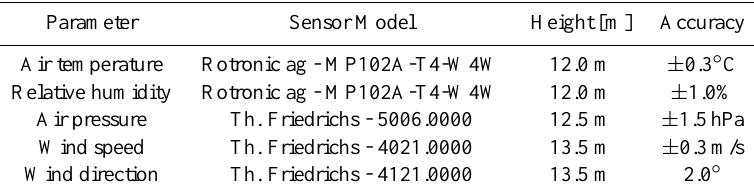
Table 1. Summary of meteorological sensors deployed on the ODAS Italia 1 buoy. Heights are reported in meters above the mean water line. Sensors’ accuracies have been extracted from the correspondent